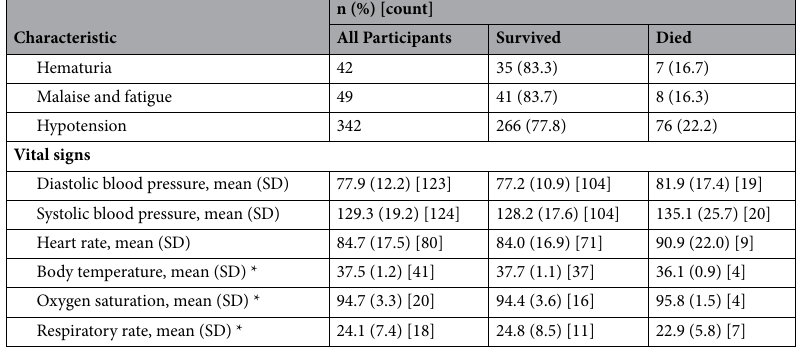
Table 1. Descriptive characteristics of the UK Biobank cohort with positive COVID-19 test results. Pre- existing medical conditions included only when reported more than one week prior to COVID-19 positive test result. Symptoms and vitals included only from primary care (GP) records when reported within + /- two weeks of COVID-19 positive test result. MND = motor neurone disease; MS = multiple sclerosis; HD = Huntington’s disease. * Oxygen saturation, respiratory rate, and body temperature were included in the initial analysis, however, they were removed from the model due to low data